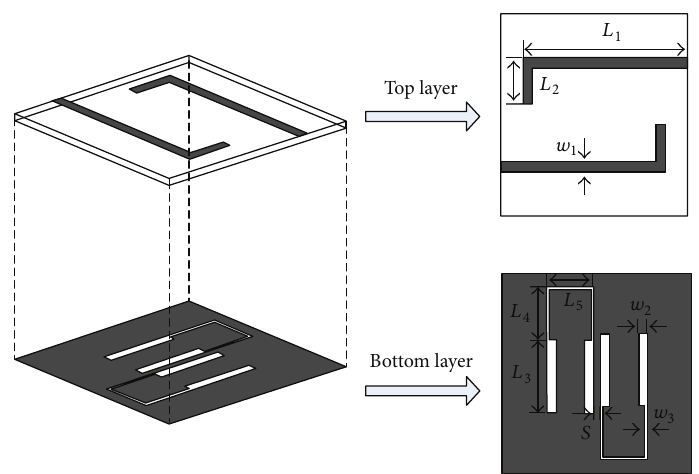
Figure 1: Schematic views of the proposed filter.